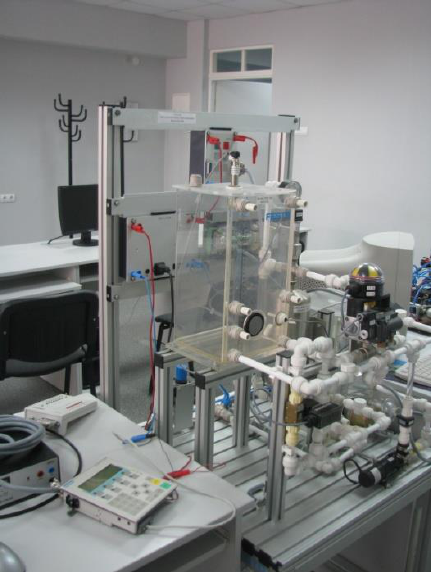
Figure 6. Hydraulic Station for the study of continuous processes